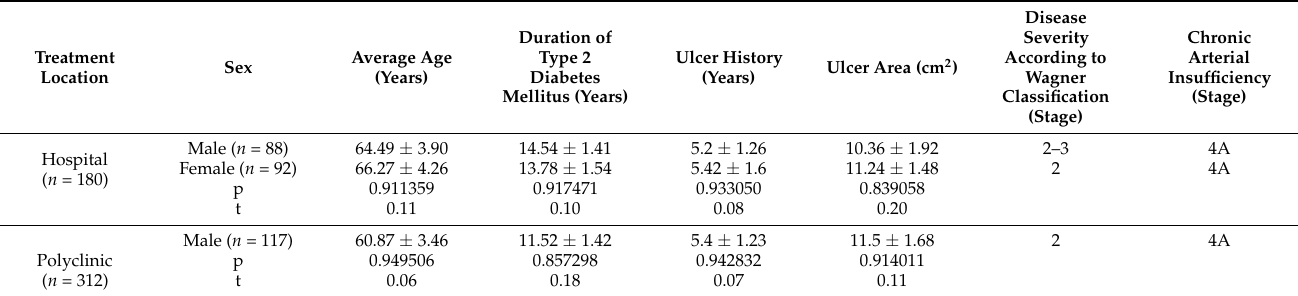
Table 4. Characteristics of patients’